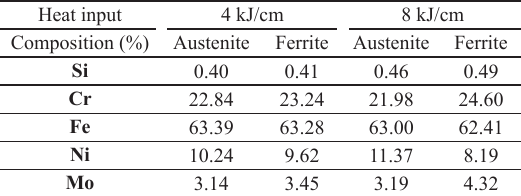
Table 4. Average values of the elements present in the austenitic and ferritic phases as a function of heat